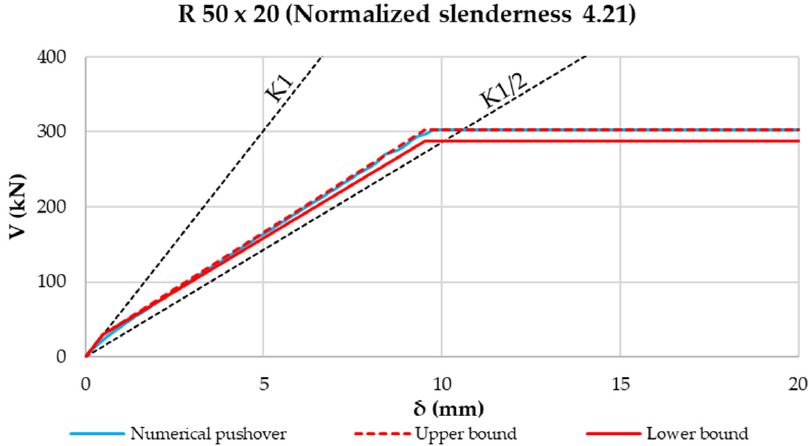
Figure 12. Comparison between analytical pushover curves and numerical one for the profile R 50 × 20. Some like “x” means “×”.